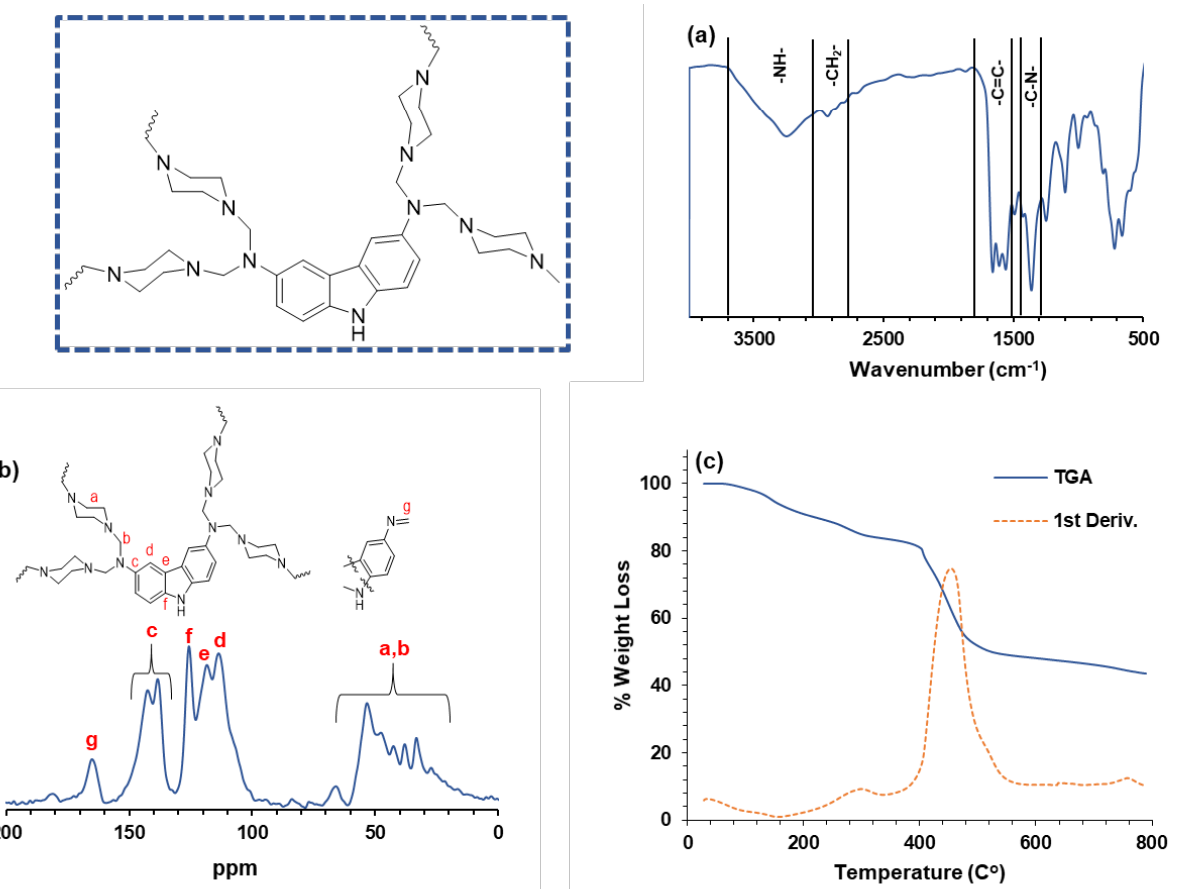
Figure 1. ( a ) FT − IR spectrum of MXM Copolymer. ( b ) The solid 13 C − NMR spectrum of MXM Copolymer. ( c ) Thermogravimetric analysis (TGA) and the first-derivative of MXM Copolymer.